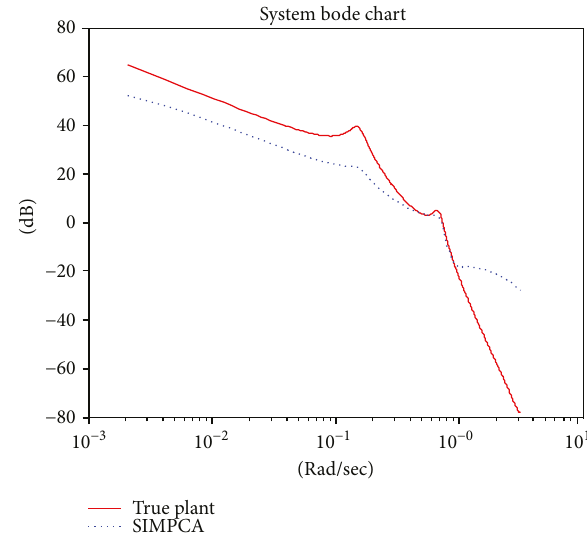
Figure 4: SIMPCA Bode amplitude tracking curve.